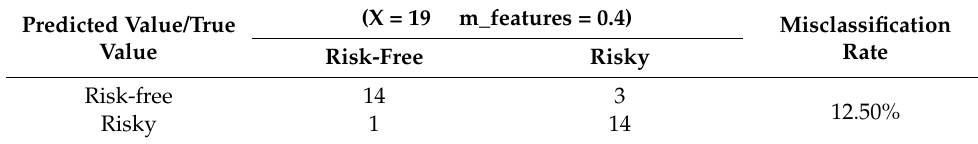
Table 4. Initial parameters with the minimum misclassification rate.